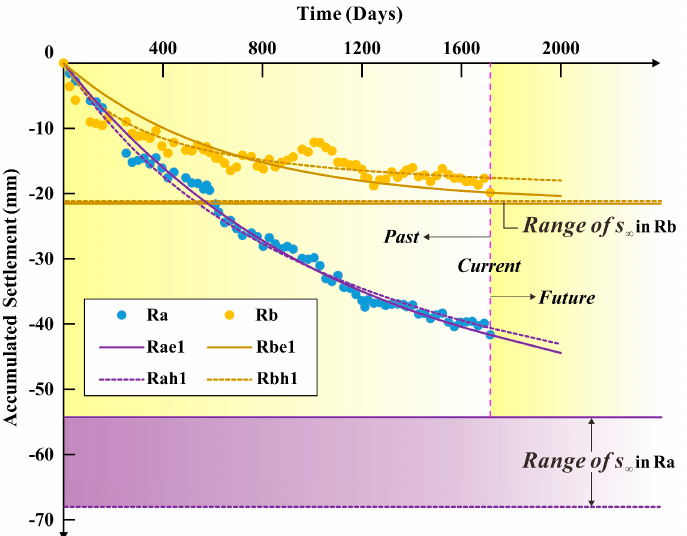
Figure 6. The predicted settlement curves derived from the three-point modified exponential (TME) method ( t 1 = 0; prediction models in Ra and Rb are labeled as Rae1 and Rbe1) and hyperbolic (HY) method ( t 0 = 0; prediction models in Ra and Rb are labeled as Rah1 and Rbh1).